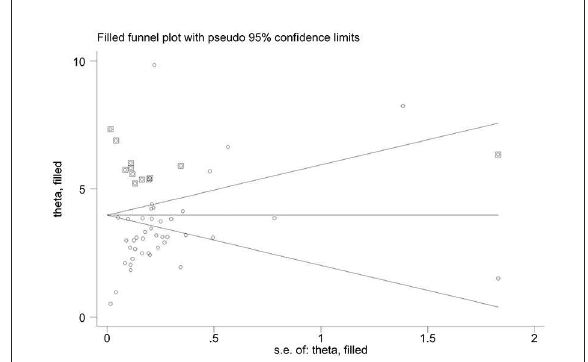
FIGURE5 Trim-and-fill analysis estimated the number of possible missing studies for the vitamin E concentration in mature milk. The squares represented the possible missing